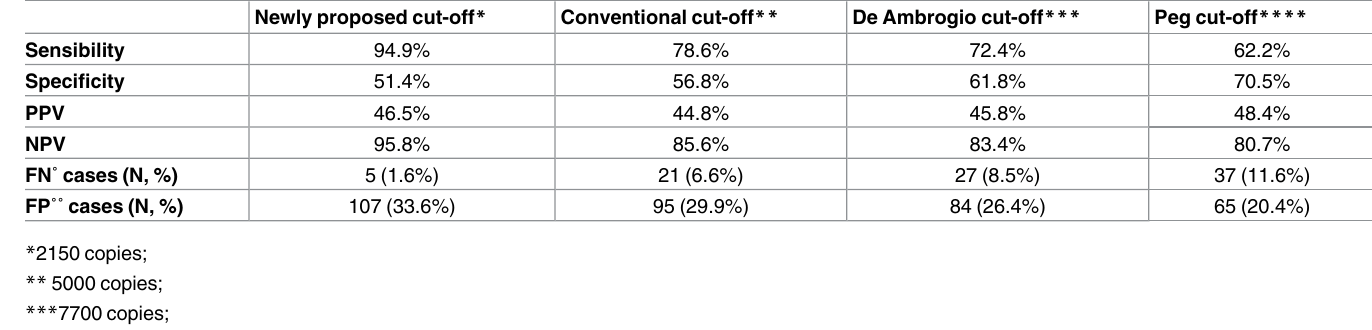
Fig 1. ROC curve. The new cut-off of cytokeratin 19 mRNA copy number obtainedby the ROC curve. Youden’sindex identifiesthe optimal value at 2150 copies. Table 4. Comparison of our new proposed OSNA cut-off with the conventional figure and two other alternativesfrom literature in the identification of patients with positive ALND.